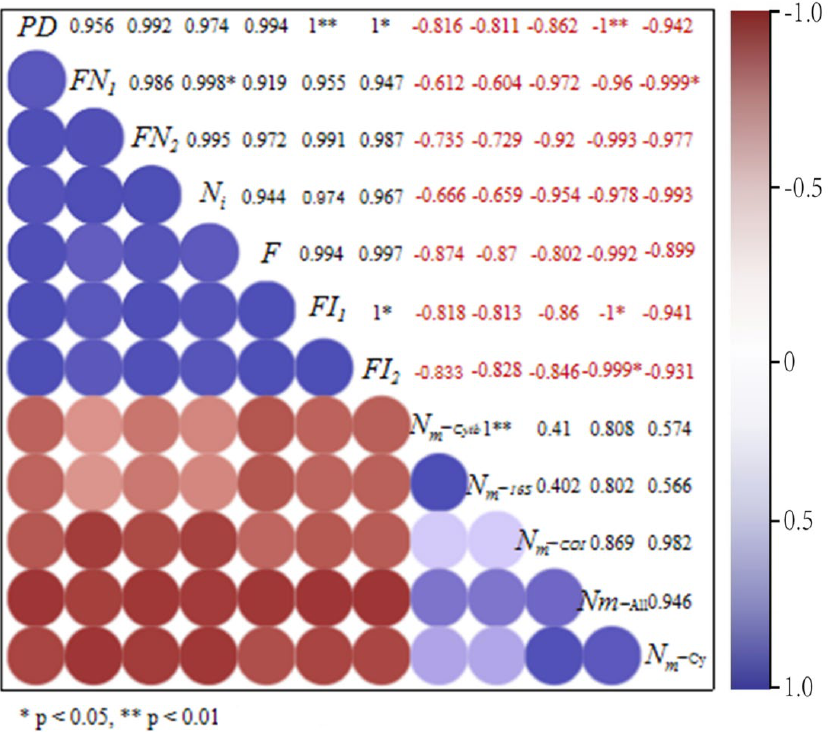
Figure 12. Correlation analysis of Erythroneurine leafhoppers habitat fragmentation and gene−flow.